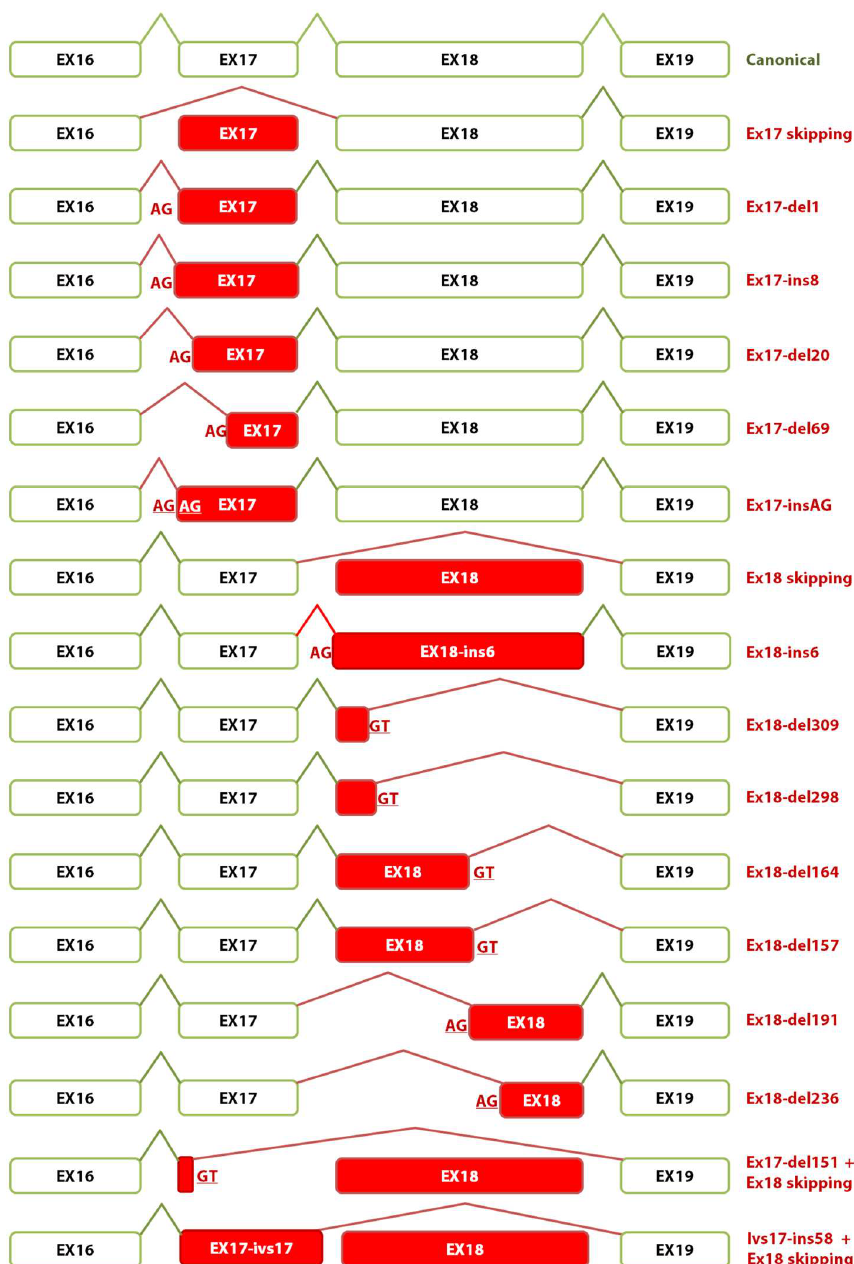
Fig 5. Schematic representation of splicing events and transcripts generated by wild type and mutant minigenes. Exons and splicingreactions exons are representedby boxes and brokenlines, respectively. Anomalous/skippedexons and aberrantevents are shown in